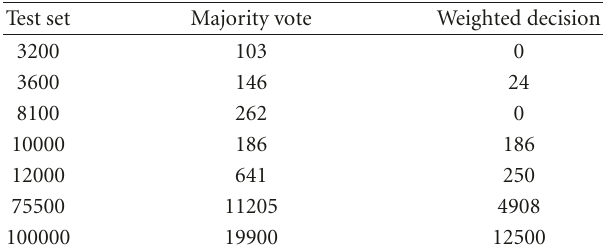
Table 4: Number of misclassified